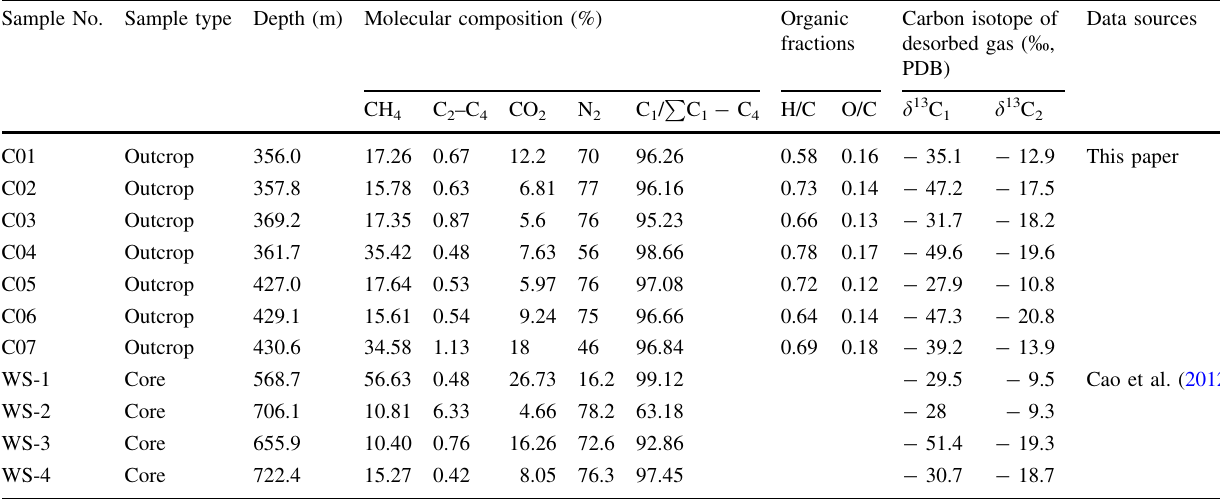
Table 2 Sample information, molecular and isotopic compositions of coal samples Sample No. Sample type Depth (m) Molecular composition